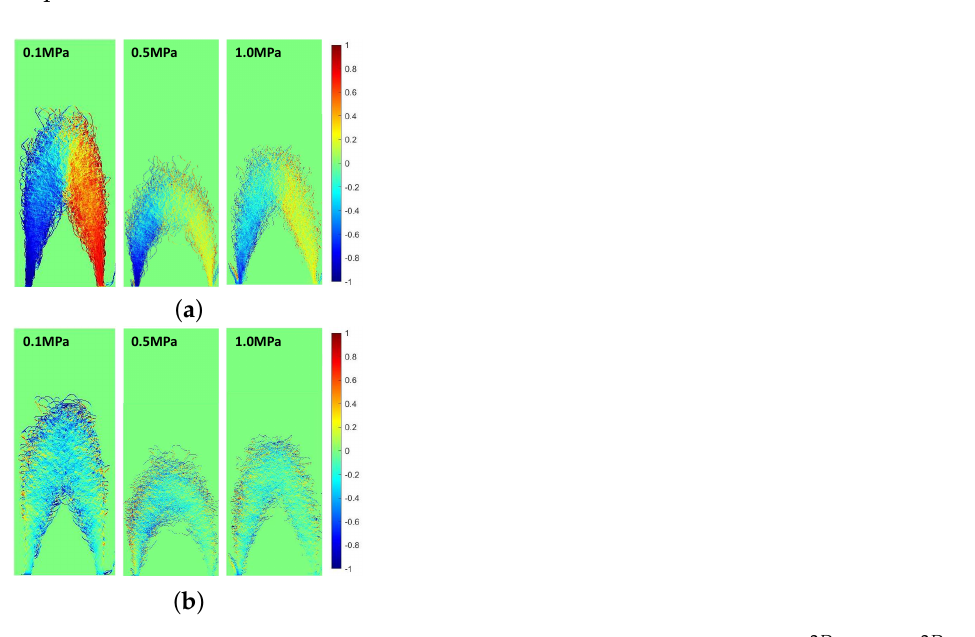
Figure 9. Pressure effect on the averaged normal vector in x and y direction. ( a ) (cid:104) n 2 D x (cid:105) s ; ( b ) (cid:104) n 2 D y (cid:105) s